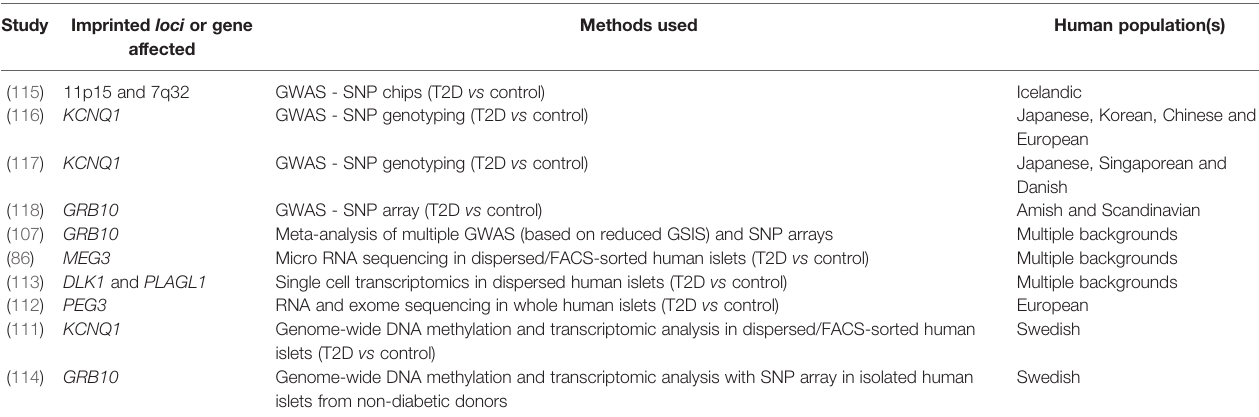
TABLE 1 | Imprinted gene candidates for conferring susceptibility to type 2 diabetes. Study Imprinted loci or gene